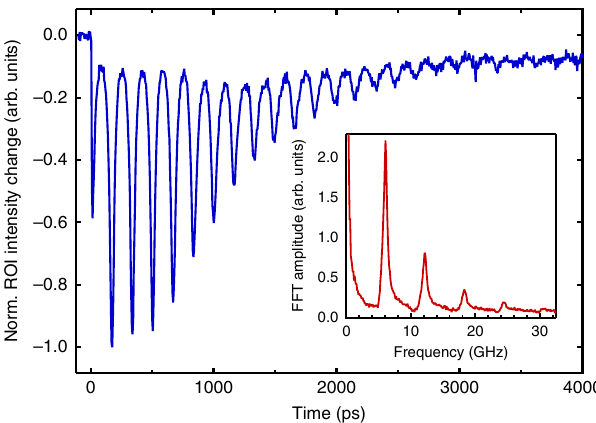
Fig. 3 Region-of-interest (ROI) intensity analysis of transient lensing dynamics. ROI difference intensity (relative to before time zero) as a function of time delay. A typical ROI is denoted in Fig. 2b (different data set). The inset shows the FFT of the trace, with a fundamental frequency of 6.05 GHz (i.e. T = 165 ps). The objective lens current was set to 0.7 A and the intermediate lens current was set to 0.65